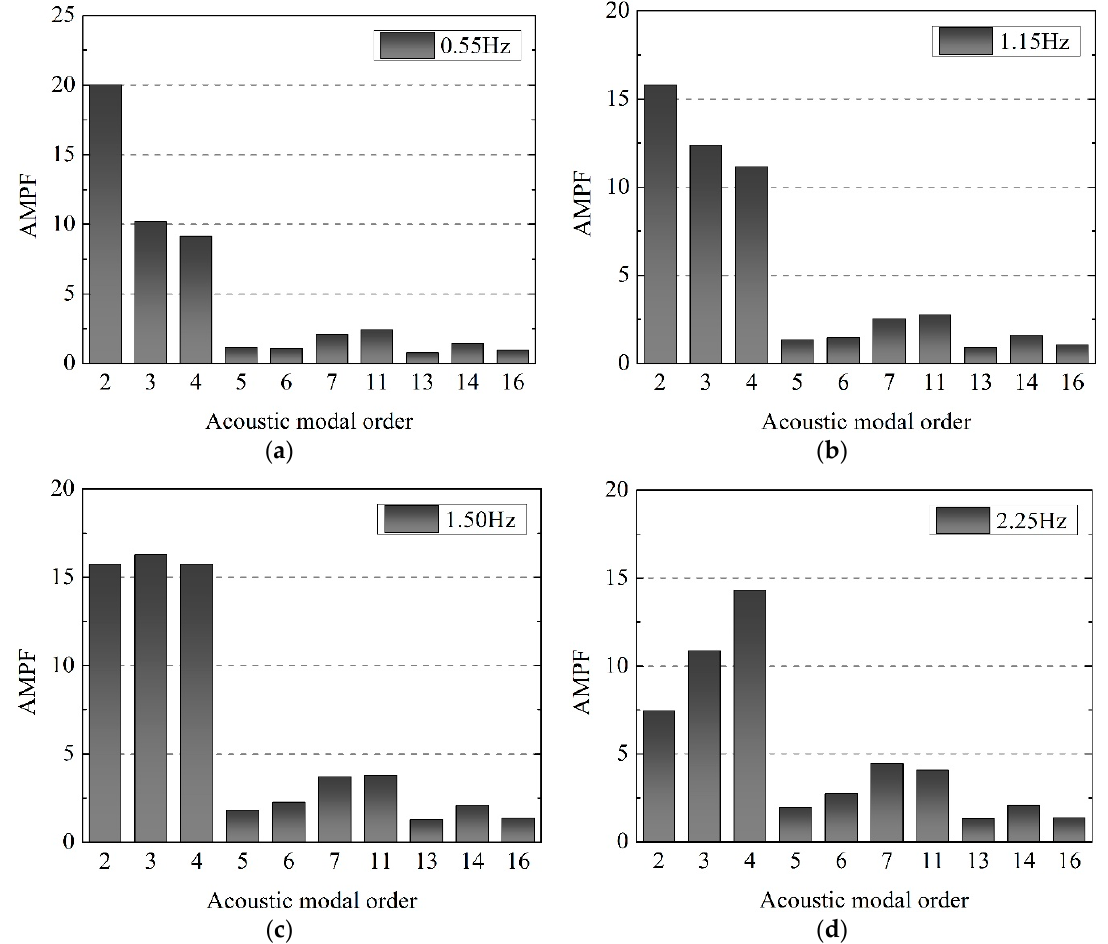
Figure 22. Acoustic modal participation factors of peak frequency of: ( a ) 0.55 Hz; ( b ) 1.15 Hz; ( c ) 1.50 Hz; ( d ) 2.25 Hz.